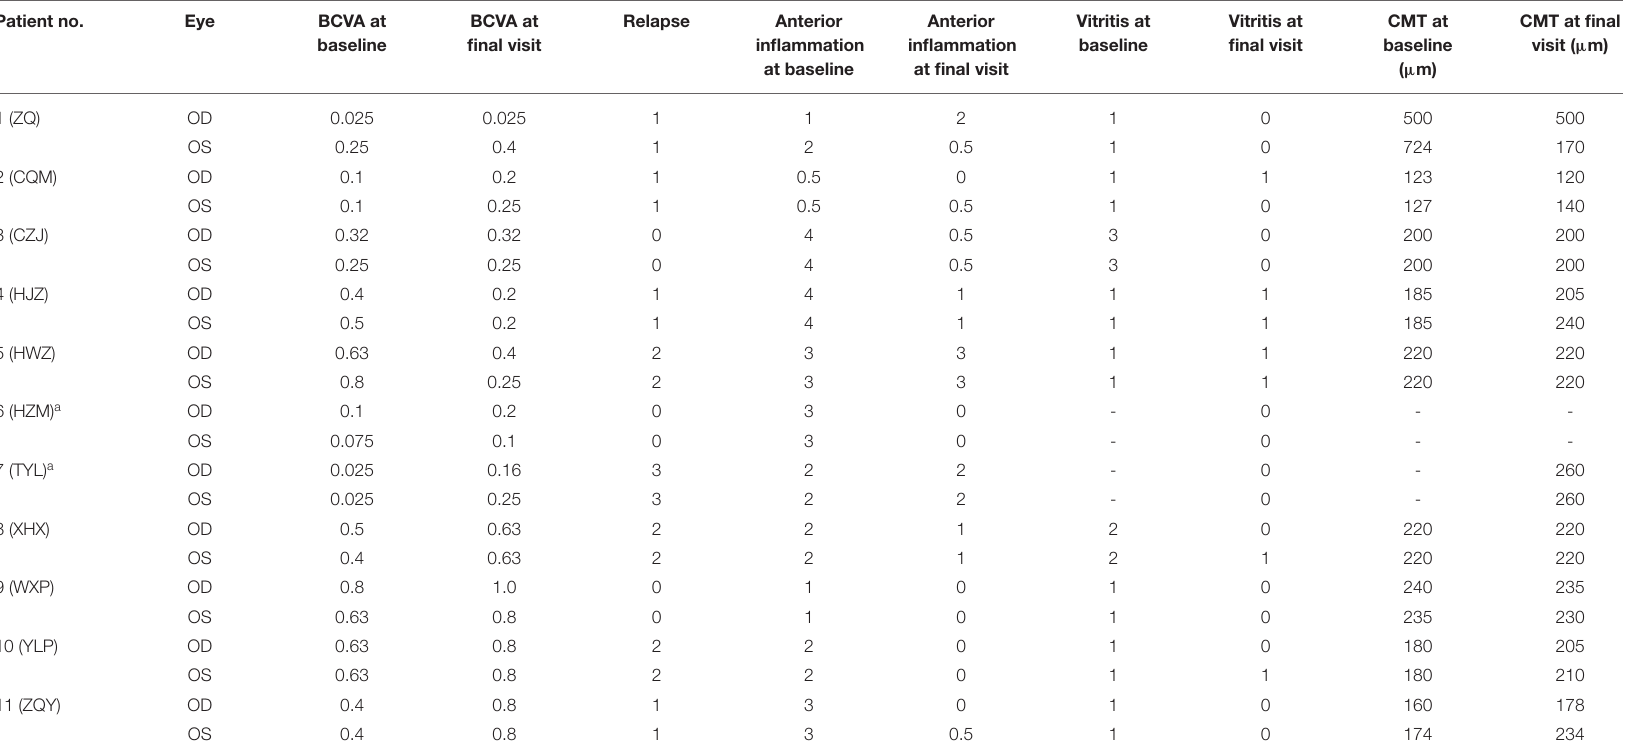
TABLE 2 | Ocular parameters of 11 refractory VKH patients. Patient